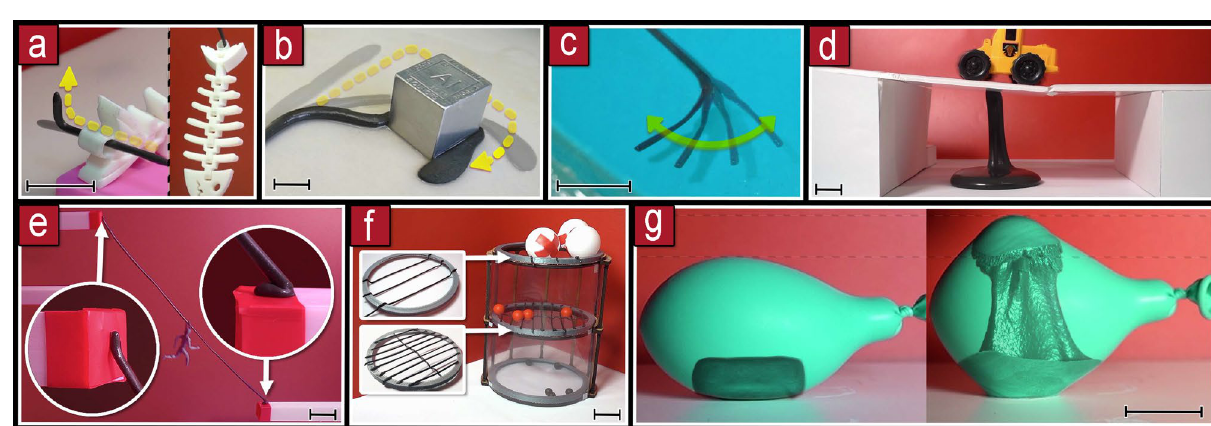
Figure 5. Use cases. (a) A hook to grab a small object. (b) A larger hook to drag a heavier object, can pull up to 20 kg. (c) Operation under water. (d) Lifted column as a support structure. (e) Filament sticking to separated places to connect them. (f) Filaments stacked at different distances for selective filtering. (g) Heating of the material inside a container using microwaves for being able to expand and contract it dynamically, after solidification it maintains the container expanded. Scale bars are 3